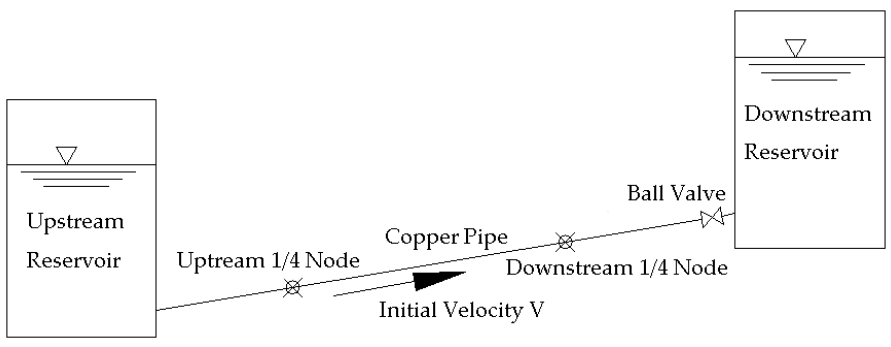
Figure 1. Sketch of reservoir-pipe-valve experiment device.